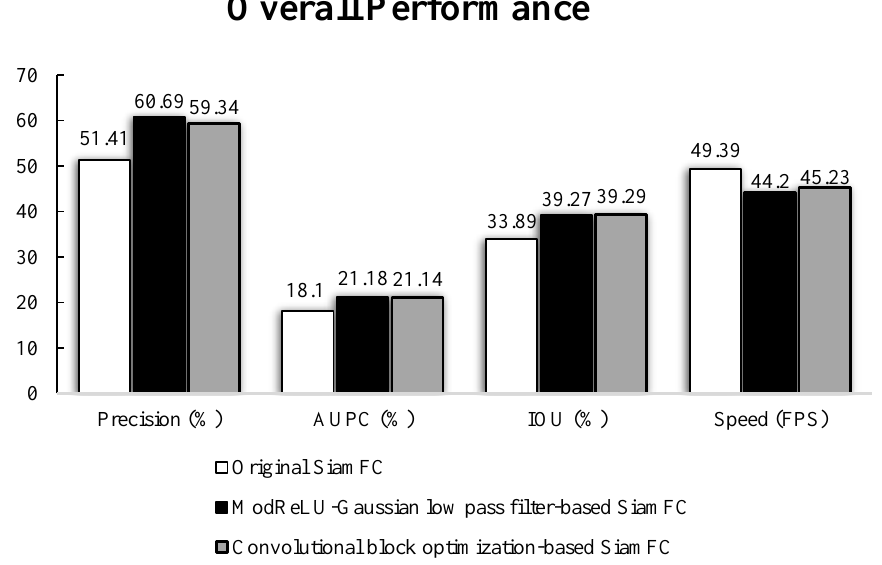
Figure 13. Results comparison histogram of our proposed methods and original SiamFC tracker performances.